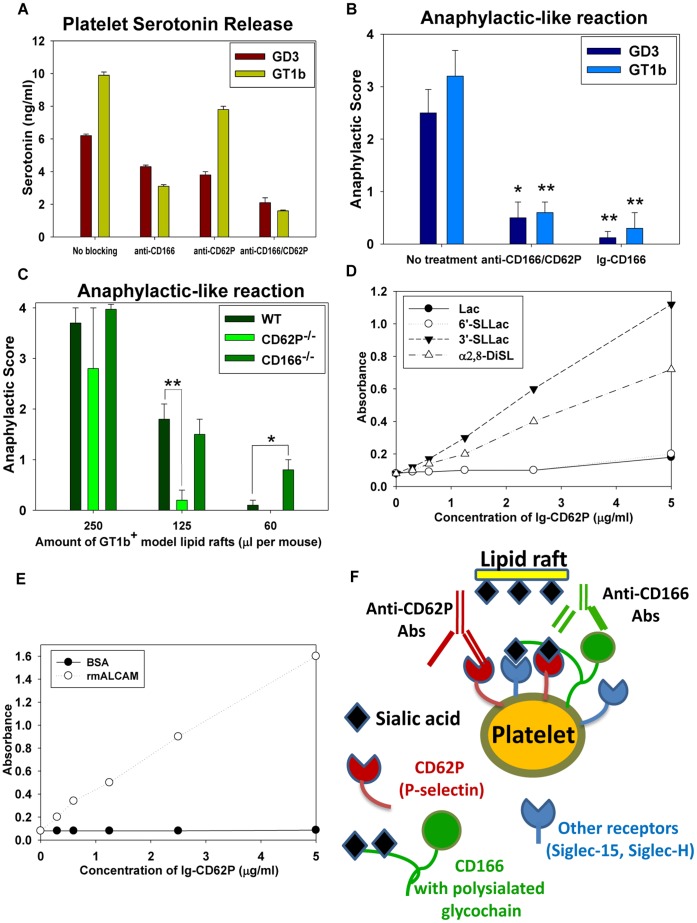
Lipid rafts engage platelet receptors specific to sialated gangliosides.(A) The effect of anti-CD62P and anti-CD166 mAbs on the platelet serotonin release in response to the model lipid rafts containing GD3 and GT1b in vitro. The serotonin release was measured (see
Figure 3
) in the presence of anti-CD62P and anti-CD166 mAbs. (B) The effect of anti-CD62P and anti-CD166 mAbs or the CD166-Fc fusion protein on the platelet degranulation iduced by the model lipid rafts in vivo. Anti-CD62P and anti-CD166 mAbs were injected i.v., and the model lipid rafts containing GD3 or GT1b gangliosides were injected 30 minutes later. The model lipid rafts containing GD3 or GT1b gangliosides were pre-treated with the CD166-Fc protein and injected i.v. into naïve mice. All mice were then injected i.v. with the lipid rafts as described in Methods. The maximum clinical anaphylactic score (Mean ± S.E.) of the total number of animals from three experiments with four mice per group is shown (*, p<0.05; **, p<0.01; when compared to non-treated animals). (C) The lipid rafts-induce anaphylaxis in wild-type (WT), CD62P (P-Selectin)- and CD166 (ALCAM)-deficient mice. The model lipid rafts containing GT1b ganglioside were injected i.v. into naïve mice at 250, 125 or 60 µl per mouse. The maximum clinical anaphylaxis score (Mean ± S.E.) of the total number of animals from the three experiments with 4 mice per group in each experiment is shown (*, p<0.05; **, p<0.01; when compared to wild-type animals). (D) Binding of CD62P-Fc fusion protein to lactose, 6′-sialyllactose, 3′-sialyllactose and α2,8-disialic glycopolymers adsorbed onto 96 well plates. (E) Binding of CD62P-Fc fusion protein to recombinant ALCAM or BSA (control) adsorbed onto 96 well plates. (F) Schematics of multiple receptors (CD62P, ALCAM, Siglec-H and Siglec-15) on the platelets and sialated gangliosides on brain lipid rafts interaction. In addition to the interaction of sialic acid on gangliosides with CD62P and Siglecs, ALCAM has mono and poly- sialated glycoepitopes that can be recognized by CD62P and Siglec-H/Siglec-15. The antibodies to ALCAM prevent binding of masked CD62P and other siglec receptors on the platelets to the sialated gangliosides on the lipid rafts. Thus, the anti-ALCAM and anti-CD62P antibodies disrupt an intricate network of the lipid raft-sensing receptors on the platelets surface.